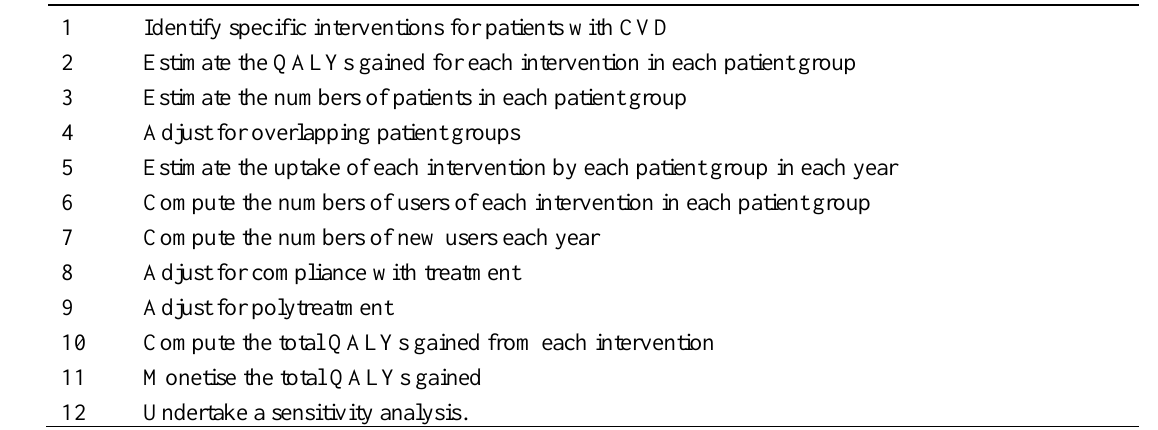
Steps for estimating the value of health gains from specific interventions to treat or prevent cardiovascular disease, CVD, as applied in Health Economics Research Group et al.,